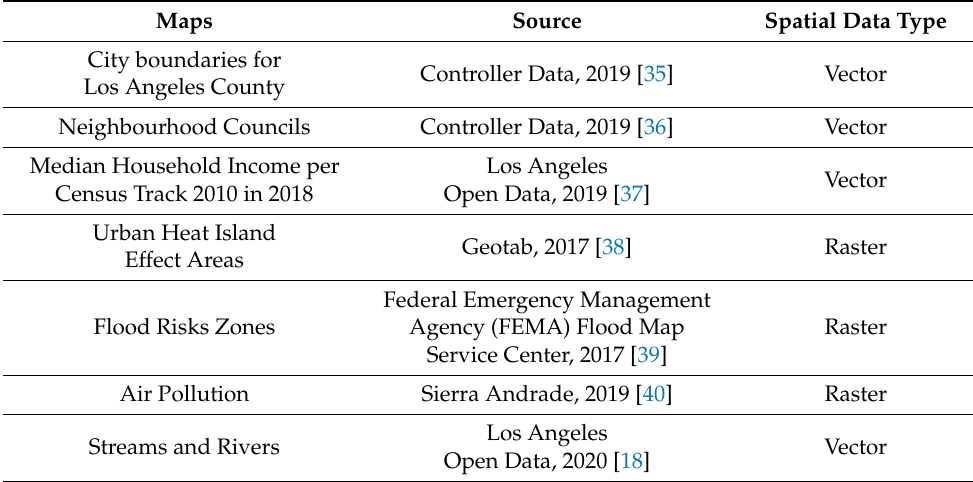
Table 3. Los Angeles case